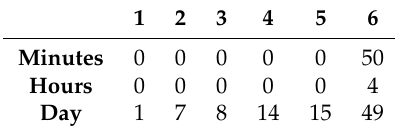
Table 1. Six decision variables of the forecast model of building consumption in the optimized case.